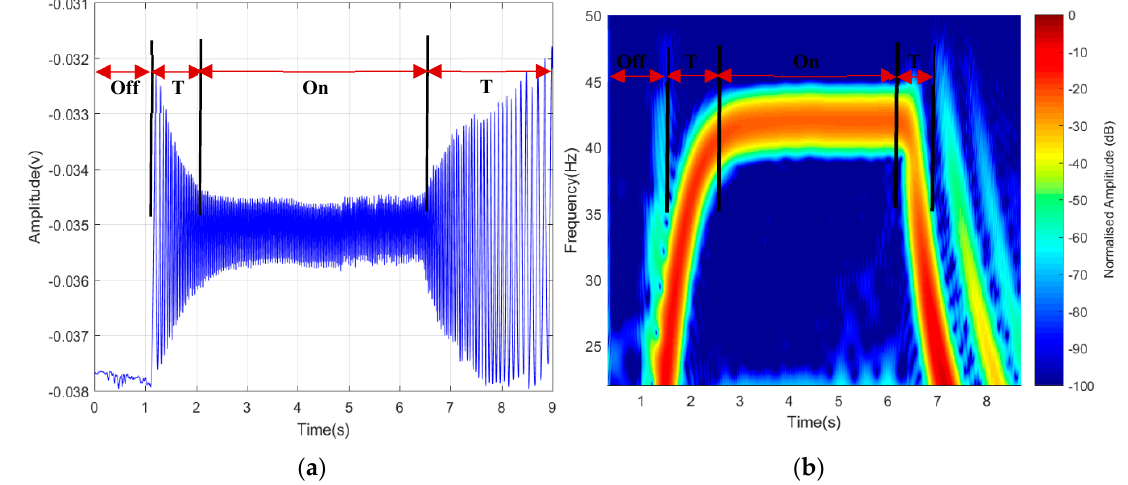
Figure 9. Detected signature of rotating blades in ( a ) time domain and ( b ) spectrogram.